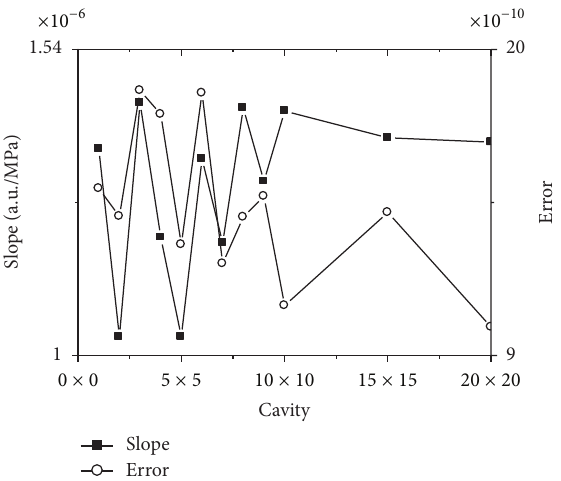
Figure 5: The slope and its error of the linear fitted curves for the resonant frequency changing with stress on 𝑥 direction which has the biggest average normalized power